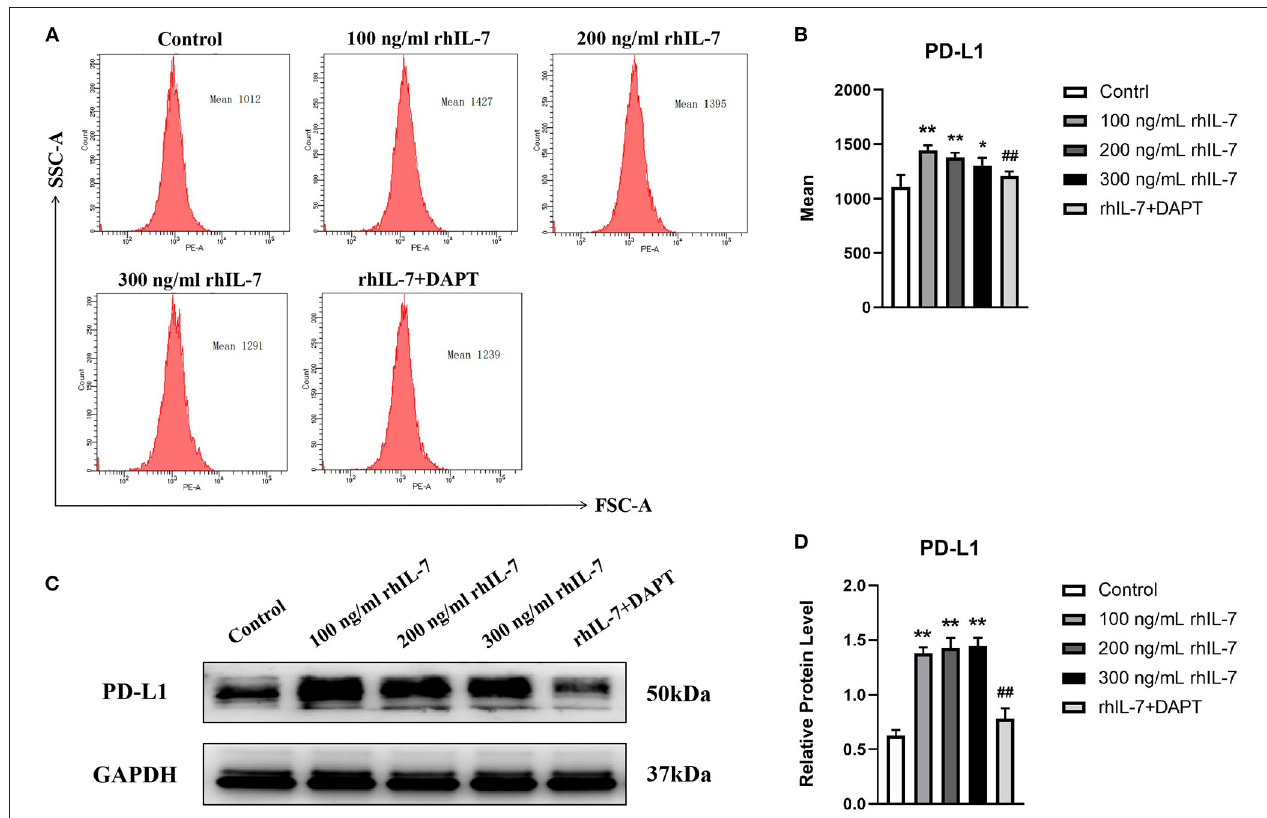
FIGURE 4 | Effects of rhIL-7 on the expression PD-L1 in hPDLCs. (A–D) After hPDLCs were treated with different concentrations of rhIL-7 for 24h, the MFI and the protein level of PD-L1 in each group were determined by FCM and WB. Representative histograms show the gating strategy of FCM analysis. n = 3, * p < 0.05. ** p < 0.01. ## DAPT group compared with 200ng/mL rhIL-7 group, p < 0.01. FCM, flow cytometry; hPDLCs, human periodontal ligament cells; MFI, mean fluorescence intensity; WB, Western